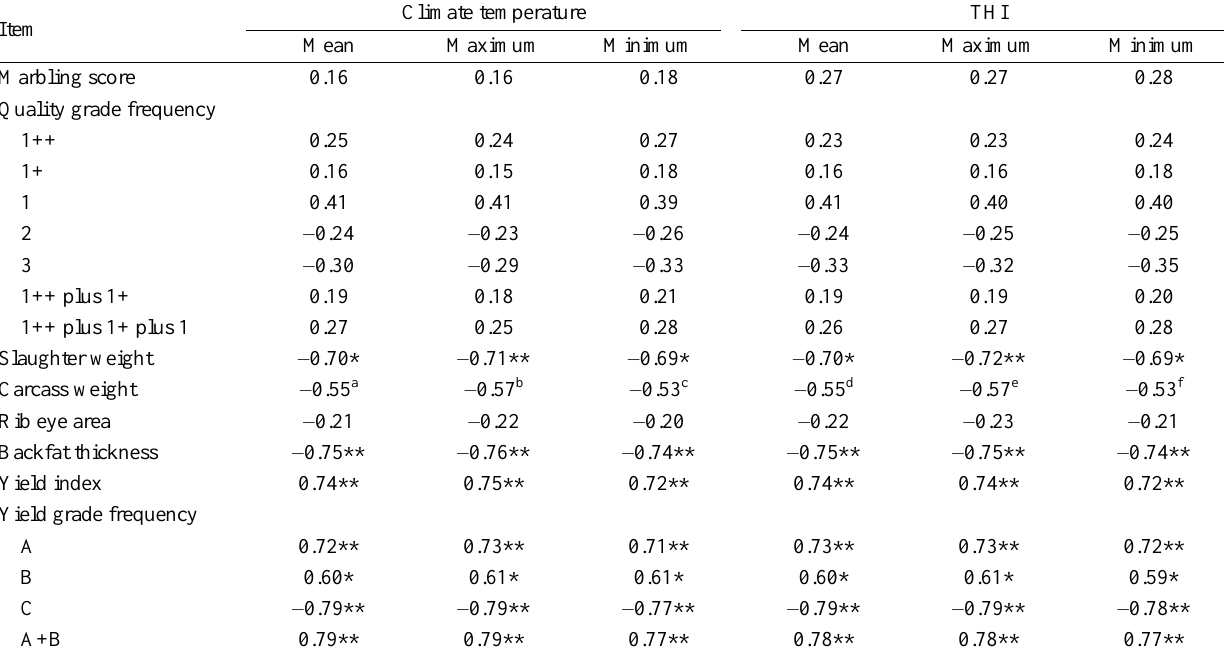
Table 8. Pearson’s correlation coefficient values for marbling score, quality grade frequency, yield grade frequency, and carcass characteristics with temperatures and temperature-humidity index (THI)